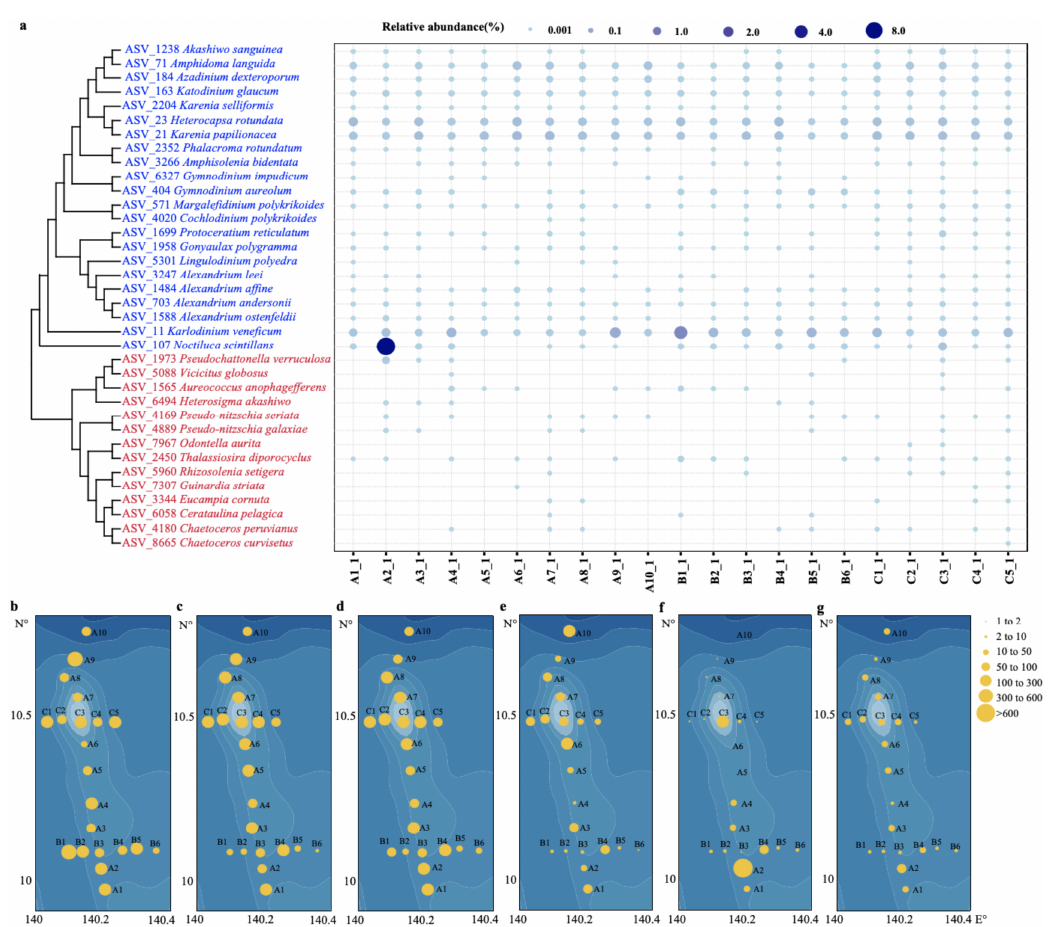
Figure 9. Distribution of HAB species in the Western Pacific seamount regions. ( a ) The distribution and relative abundance of 36 HAB species identified in the surface seawaters of the Western Pacific seamount regions. Cladogram was constructed using the 18S rDNA V4 region sequences of 36 HAB species. The sizes of the blue circles represent the species’ relative abundances; ( b ) Karlodinium veneficum (ASV_11), ( c ) Karenia papilionacea (ASV_21), ( d ) Heterocapsa rotundata (ASV_23), ( e ) Amphidoma languida (ASV_71), ( f ) Noctiluca scintillans (ASV_107), and ( g ) Katodinium glaucum